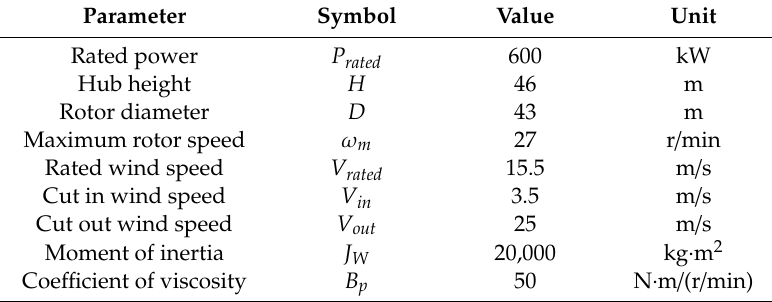
Table 2. The parameters of the hydraulic variable